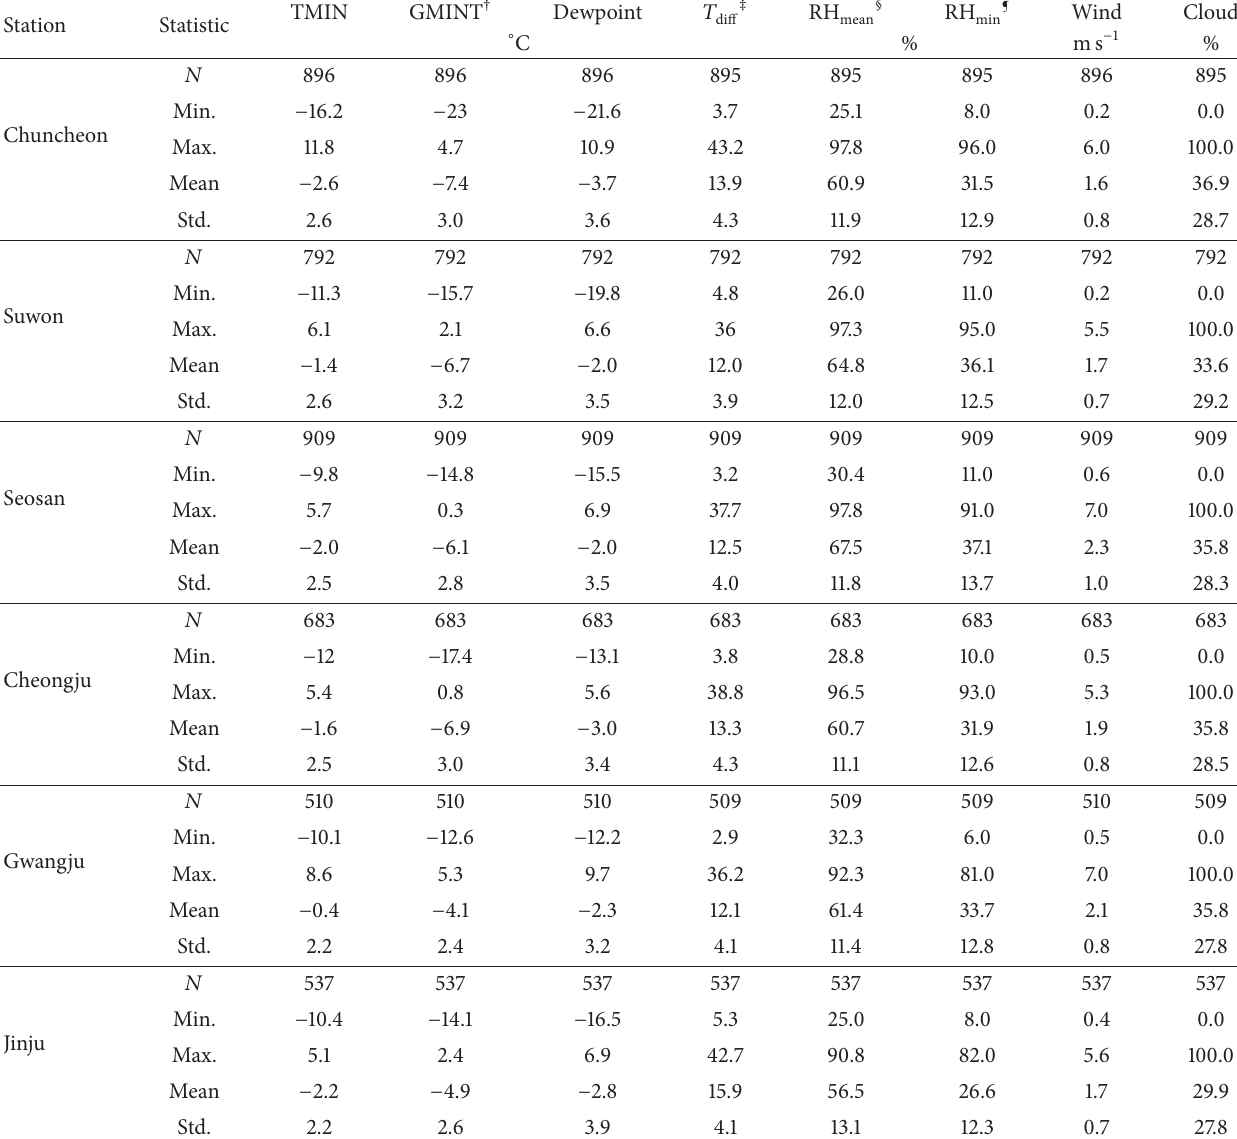
Table 1: Meteorological characteristics at frost occurrences at the study stations in